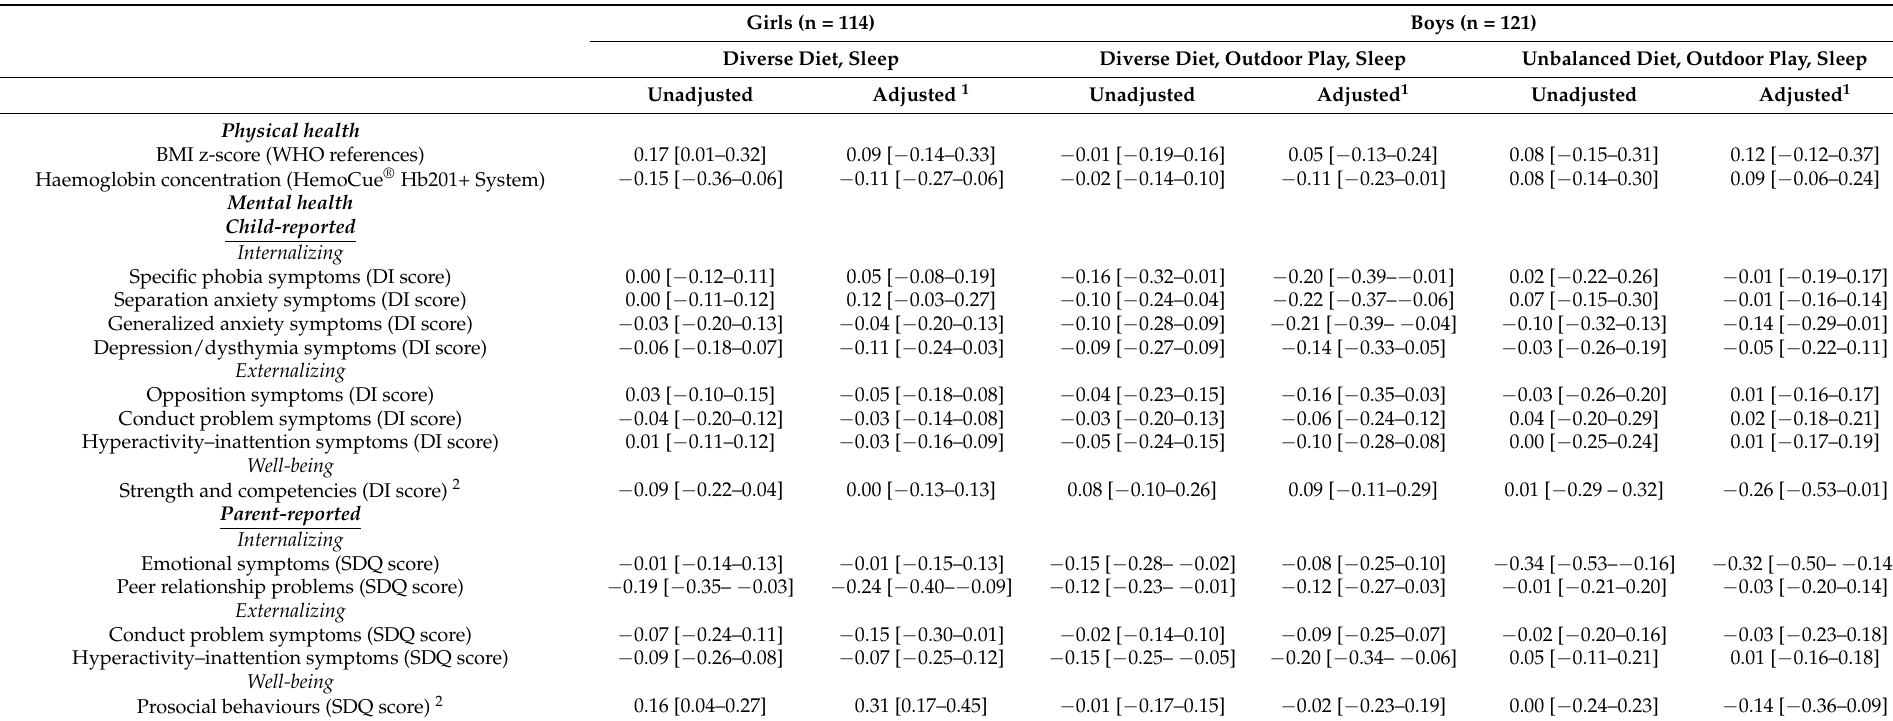
Table 4. Associations ( β [95% CI]) between lifestyle patterns and children’s physical and mental health: unadjusted and adjusted models. The ENFAMS survey. Girls (n = 114) Boys (n = 121) Diverse Diet, Sleep Diverse Diet, Outdoor Play, Sleep Unbalanced Diet, Outdoor Play,